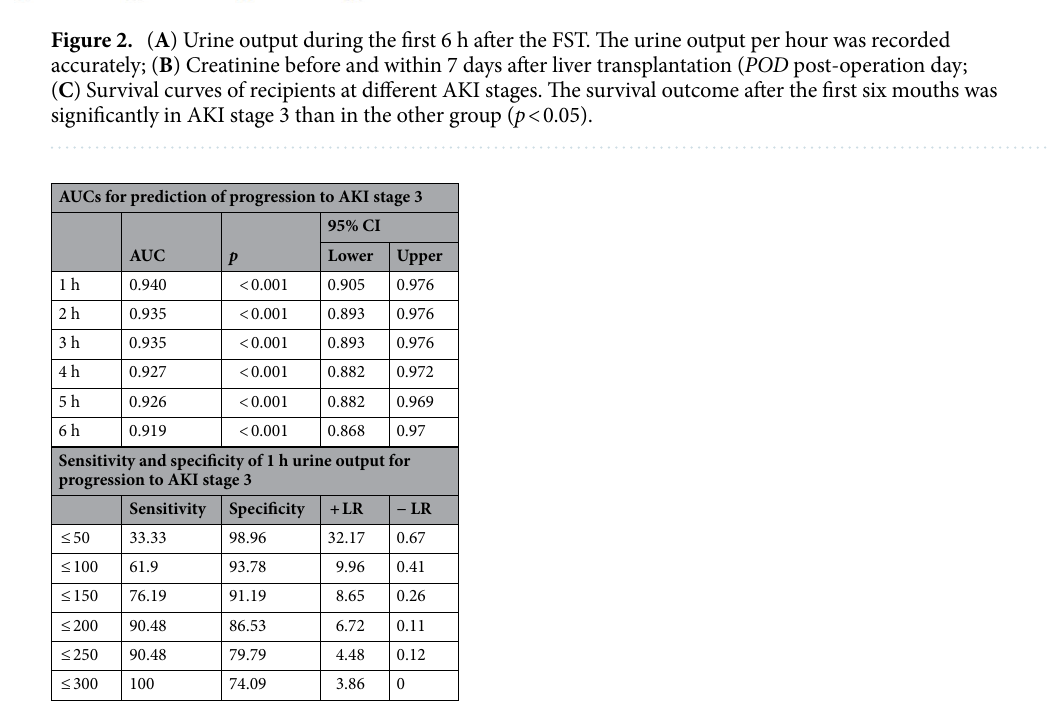
Table 2. Predictive value of different variables on AKI stage